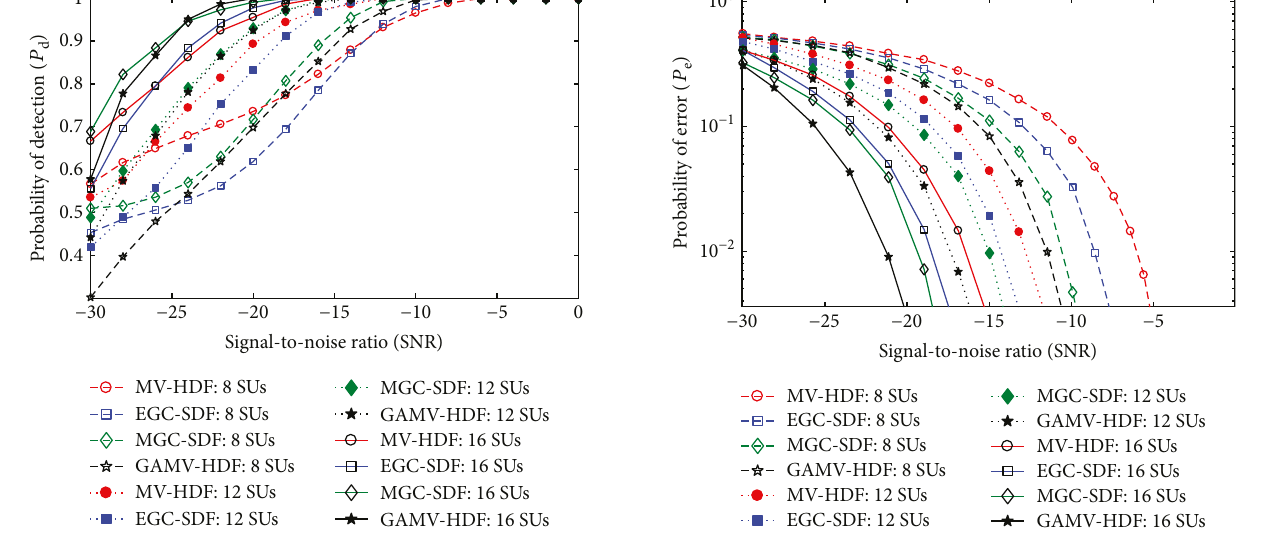
Figure 10: Probability of error versus signal-to-noise ratio at di ff erent ratios of cooperative SUs with MUs having low SNR compared with NSUs.